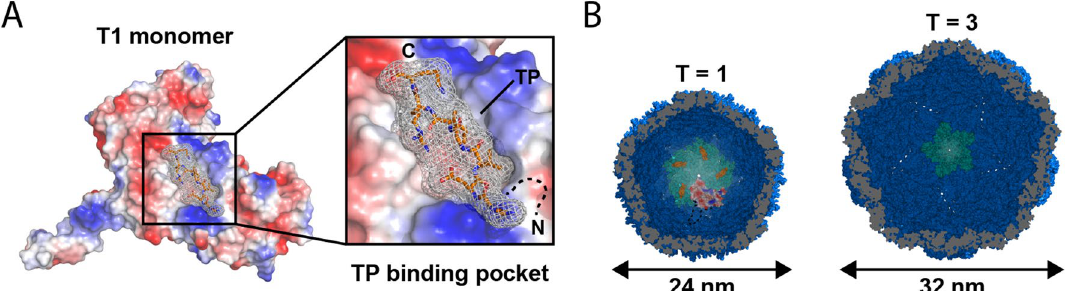
Figure 1. Encapsulin structure and cargo loading. ( A ) Electrostatic surface representation of a T. maritima T1 encapsulin protomer (PDB ID: 3DKT) in complex with its native targeting peptide viewed from the interior side of the assembled shell. The inset shows the targeting peptide binding pocket. ( B ) Cut-away views of T1 ( T. maritima ) and T3 ( M. xanthus , PDB ID: 4PT2) encapsulins viewed along the fivefold symmetry axis. A single T1 protomer (electrostatic surface) and five targeting peptides (orange) are highlighted. The protomers forming a pentameric facet in the viewing direction are shown in green.